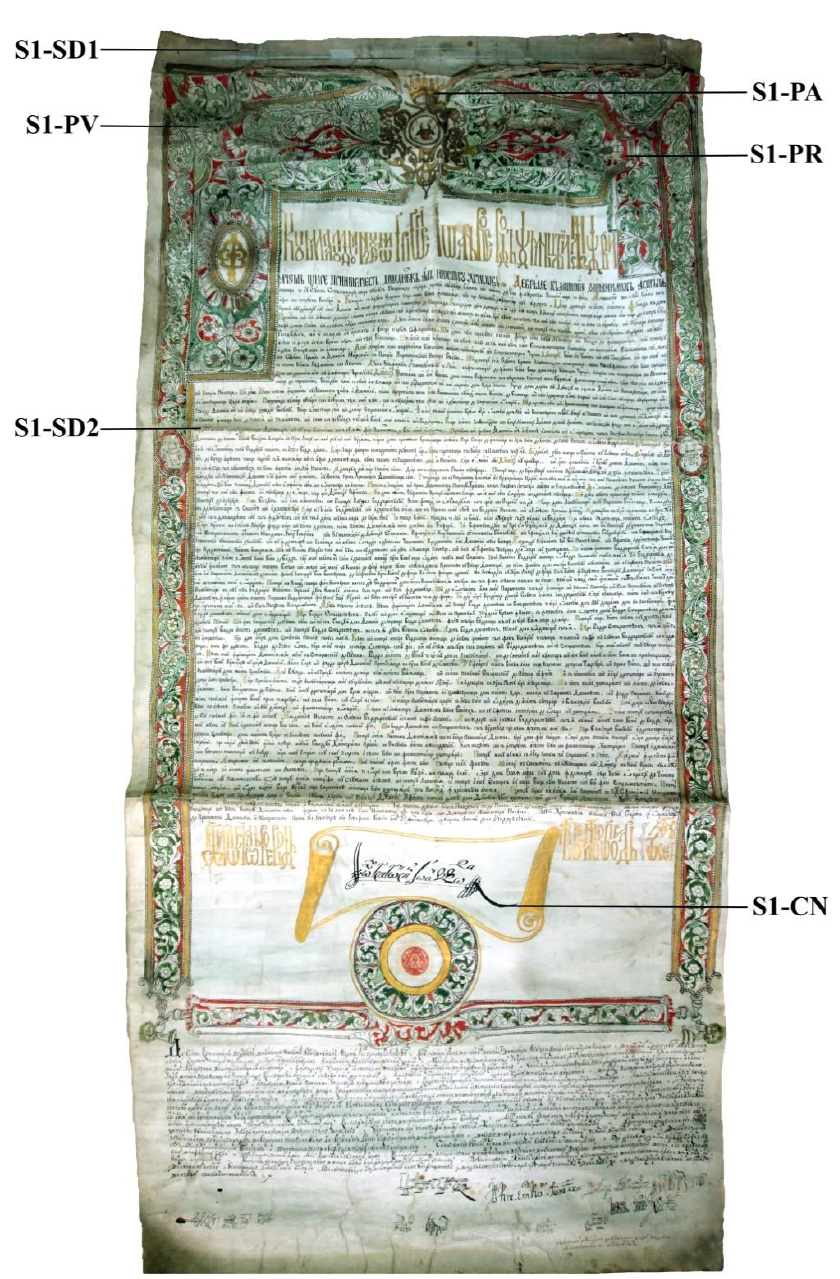
Figure 1. Parchment S1 with the index codes of the areas under scrutiny .